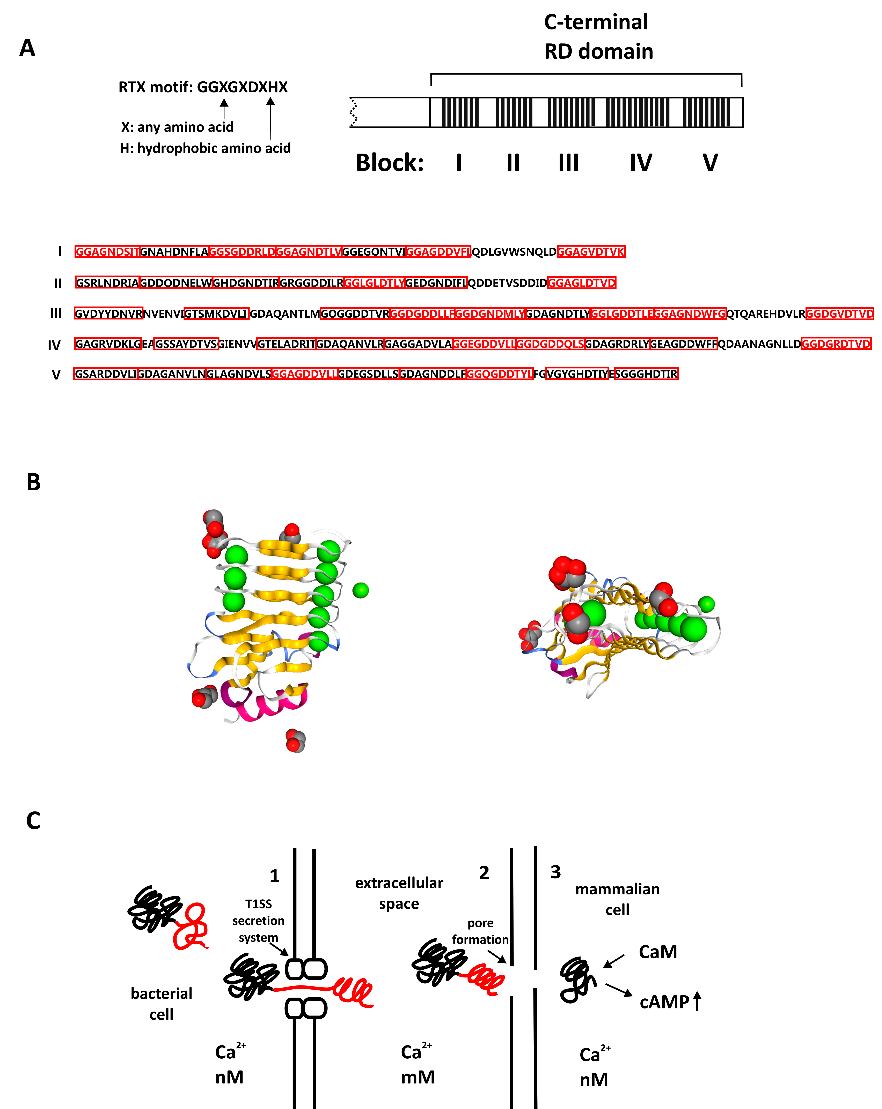
Figure 1. Structure and function of bacterial adenylate cyclase toxin (CyaA). ( A ) Structure of the C-terminal RTX domain (RD) of CyaA, with five blocks containing repeat-in-toxin (RTX) consensus. Variability of the motif can be observed in all blocks, RTX motifs in red frames, full consensus in red letters. ( B ) Left panel: calcium-bound RTX domain of bacterial toxin CyaA, β -roll structure, PDB_5CVW, right panel: the same structure from another perspective, visible narrow parallel β -roll. ( C ) Bacterial toxin with RTX domain acquires the structure upon Ca 2+ binding. 1 . Protein in bacterial cell: C-terminal domain is unstructured (red) in a low Ca 2+ concentration. 2 . Protein translocates into extracellular space through type 1 secretion system (T1SS): in a high concentration of calcium ions C-terminal domain acquires secondary structure ( β -roll) 3 . The toxin forms pores in mammalian cell membrane; part of the toxin (catalytic domain) translocates into the mammalian cell, binds calmodulin and causes detrimental increase in cellular cAMP.